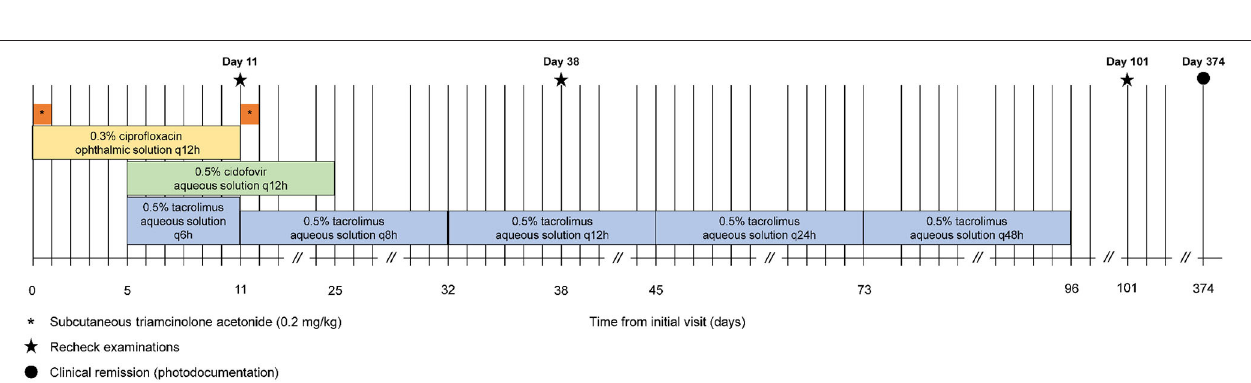
FIGURE 4 | Timeline of the cat’s clinical course and